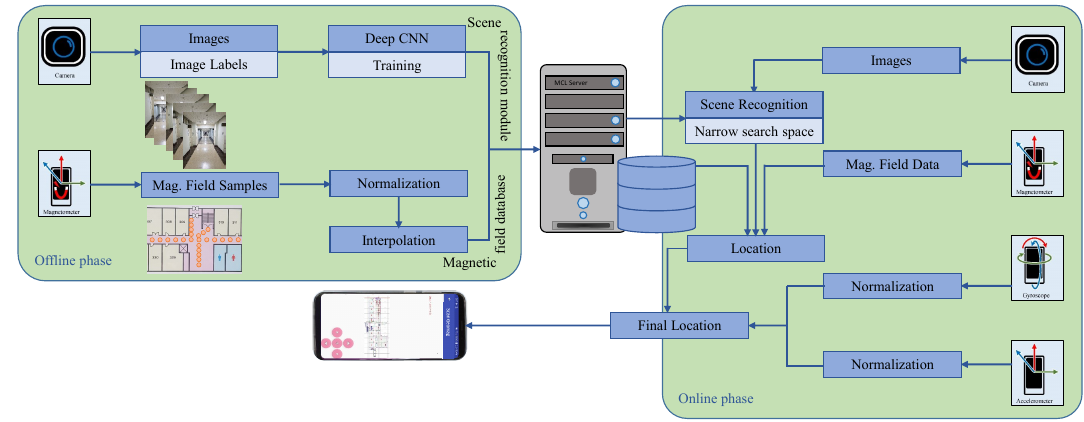
Figure 1. Architecture of the proposed